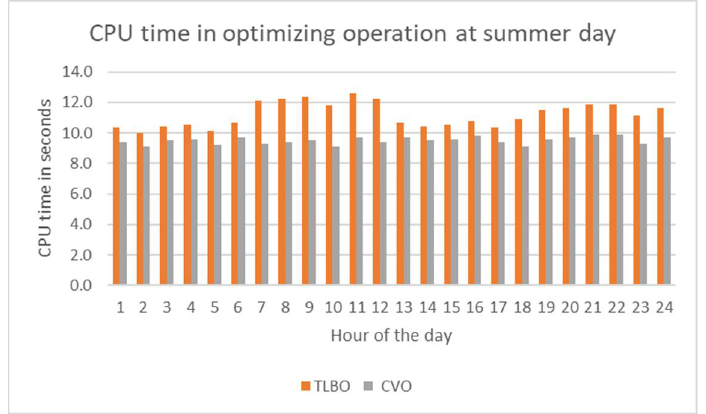
Figure 12. Convergence characteristics of TLBO and CVO.